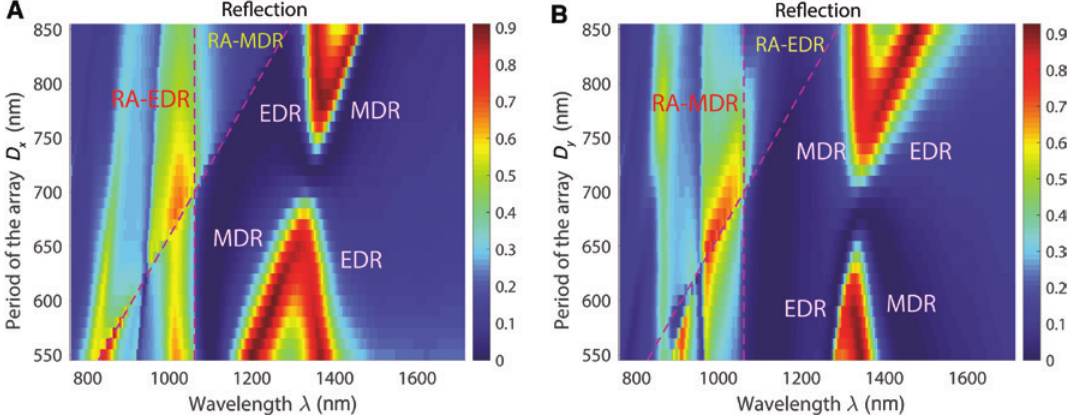
and (B) D . Figure 2: Reflection of the disk array under independent variations of (A) D x y The second period is fixed at 700 nm, and the diameter d = 500 nm is fixed and the same on both panels. In (A), changes in D dipole resonance (MDR) shift, but D and electric dipole resonance (EDR) position remain unchanged. In (B), D y but D and MDR position remain unchanged. The dashed magenta lines mark the Rayleigh anomaly wavelength: λ x = D = D = 700 nm and λ = D and λ in (A), and λ in (B). Both EDR and MDR remain on spectral distance about Δλ ≈ 200–350 nm RA-MDR x RA-MDR x RA-EDR y from the corresponding Rayleigh anomaly